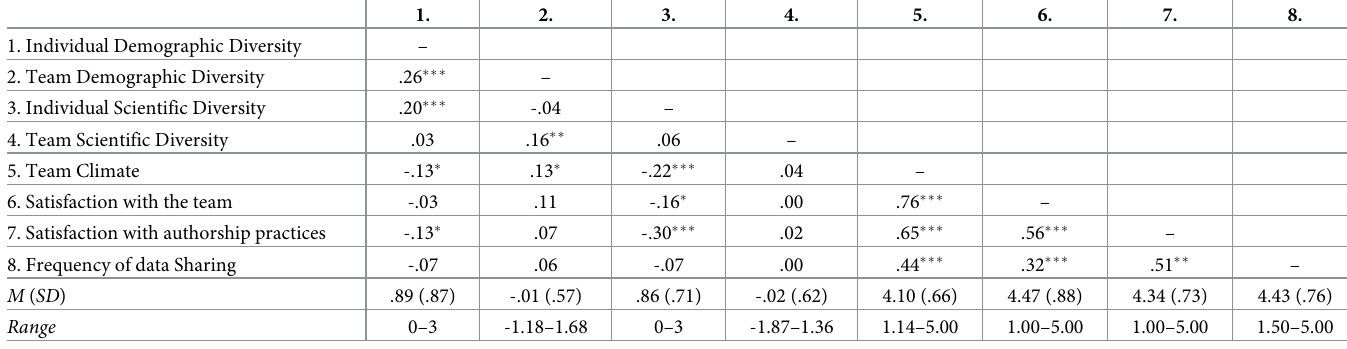
Table 3. Correlations, means, standard deviations, and ranges for participants’ responses to all study